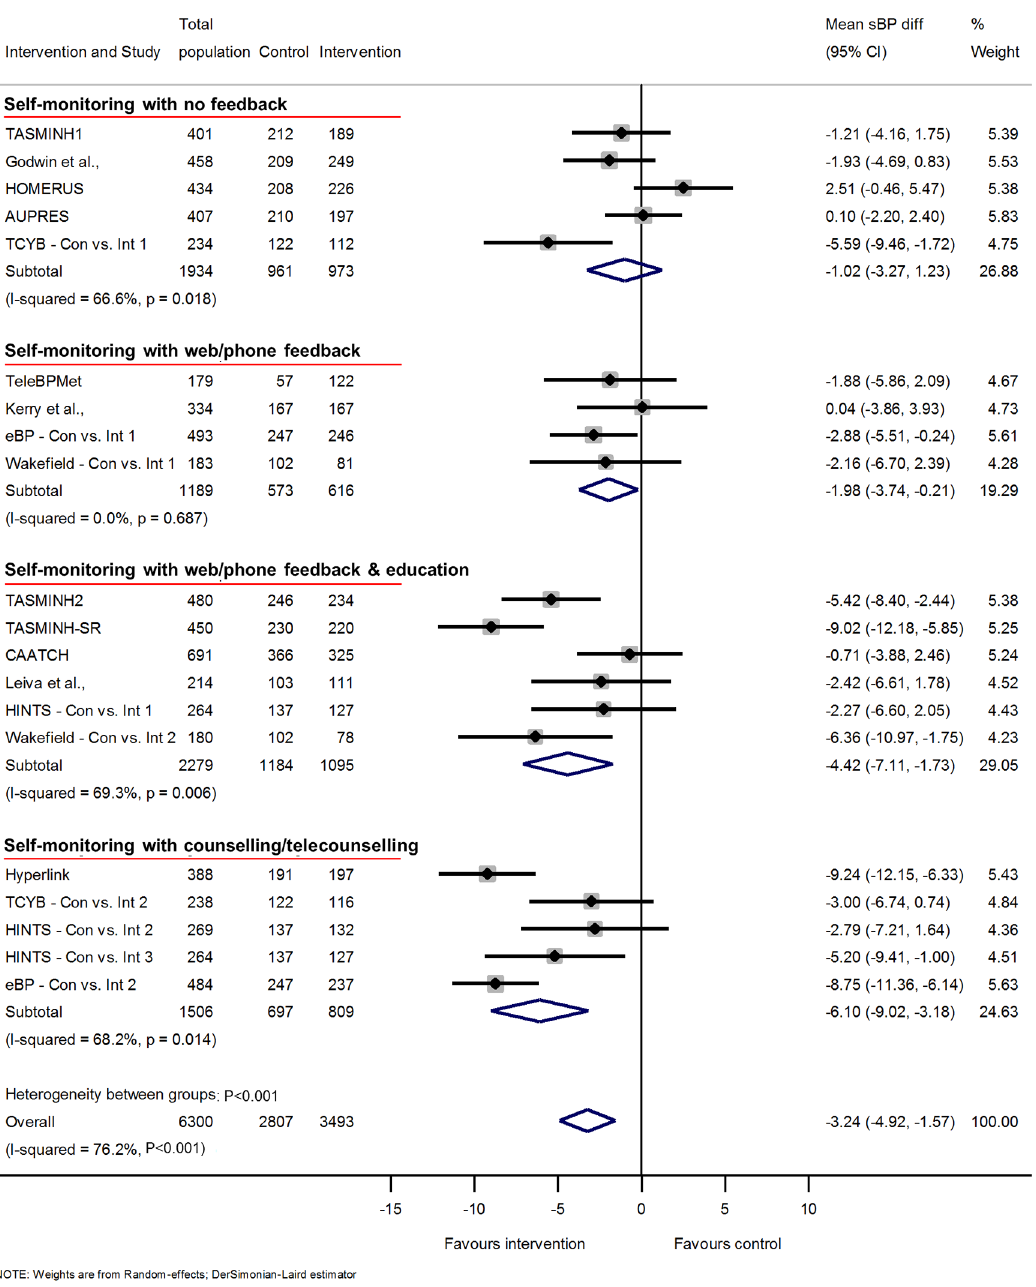
Fig 1. Impact of self-monitoring of BP on clinic sBP according to level of co-intervention support at 12 months (15 studies). Changein sBP adjusted for age, sex, baselineclinic BP, and history of diabetes. The trials are groupedinto the 4 levels of intervention, and I 2 and P values are shown for each level of intervention and for the overall analysis. Effect of self- monitoring on clinic sBP at 6 and 18 months are shown in S3 and S6 Figs, respectively.Wakefield’s study participants self- monitored for 6 months; follow-upcontinuedto 12 months. Abbreviations: BP, blood pressure; sBP, systolic blood pressure.